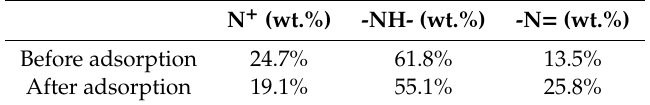
Figure 15. XPS spectra of ( a ) wide spectrum scan, ( b ) Hg 4 f and ( c ) N 1 s . Table 5. Changes in the composition of N element before and after adsorption. Table 5. Changes in the composition of N element before and after adsorption.